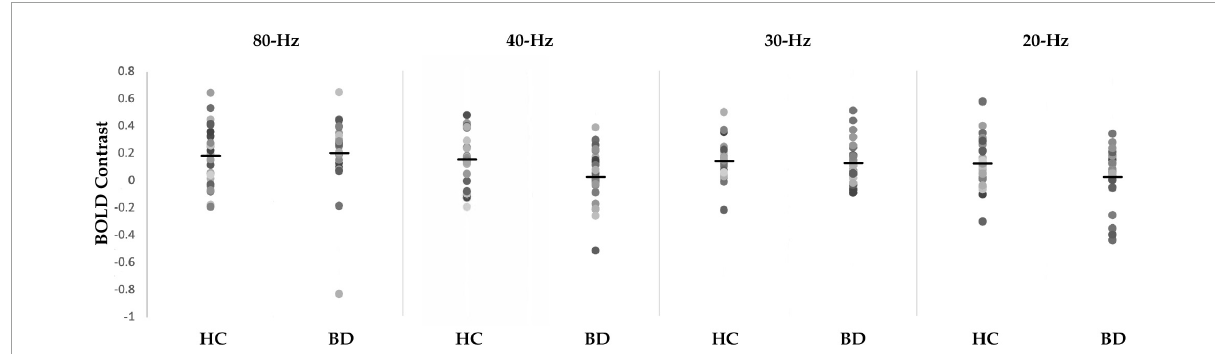
FIGURE1 Scattergrams of the blood oxygen level-dependent (BOLD) contrast of 80-, 40-, 30-, and 20-Hz auditory steady-state response stimulation (ASSR) between healthy controls (HC) group and bipolar disorder (BD) group in the right Brodmann areas 41 and 42. The BD group showed significantly decreased ASSR-BOLD signals to the 40-Hz stimuli compared with HC group ( p = 0.029). Horizontal lines indicate group means.